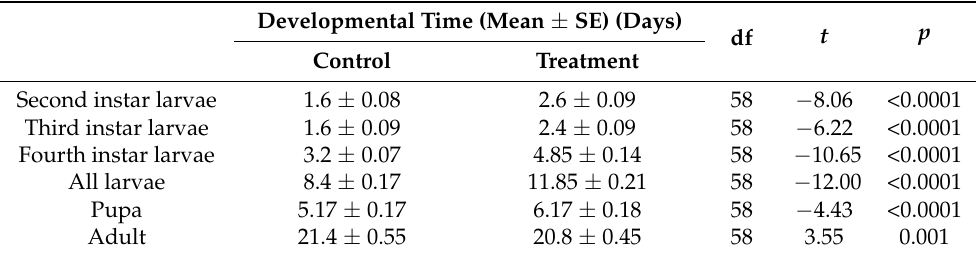
Table 3. Effects of sublethal concentration of farnesyl acetate on the developmental period of P. xylostella. df, degrees of freedom.